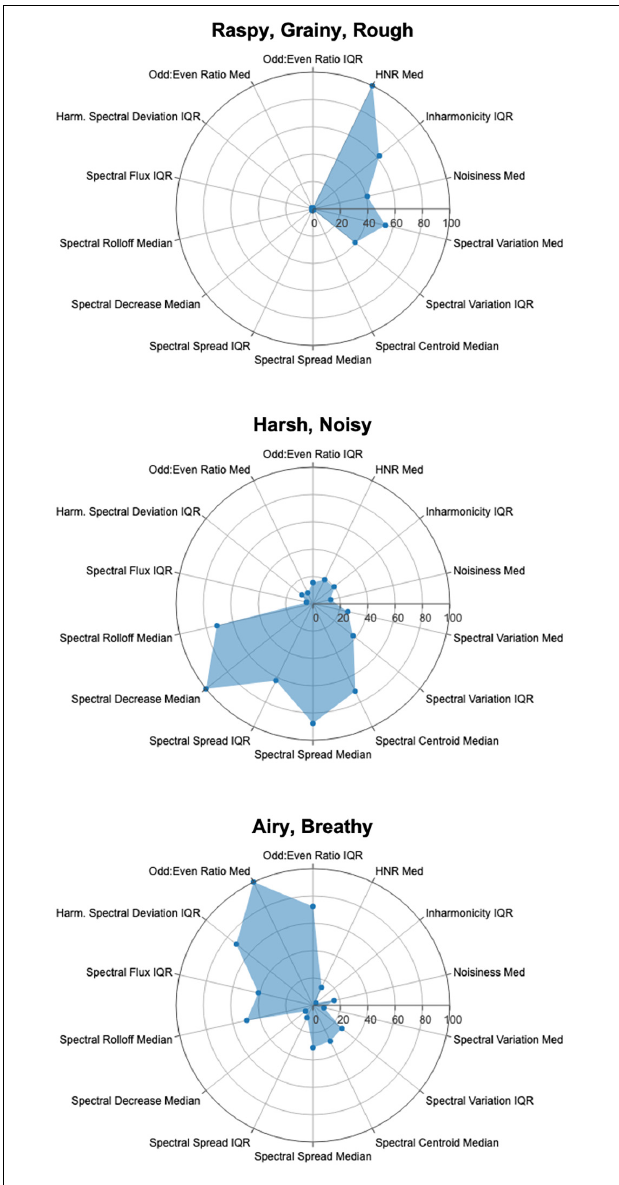
FIGURE 5 | Radar plots of 14 most important features across the three semantic categories in the random forest models. Radius represents relative variable importance